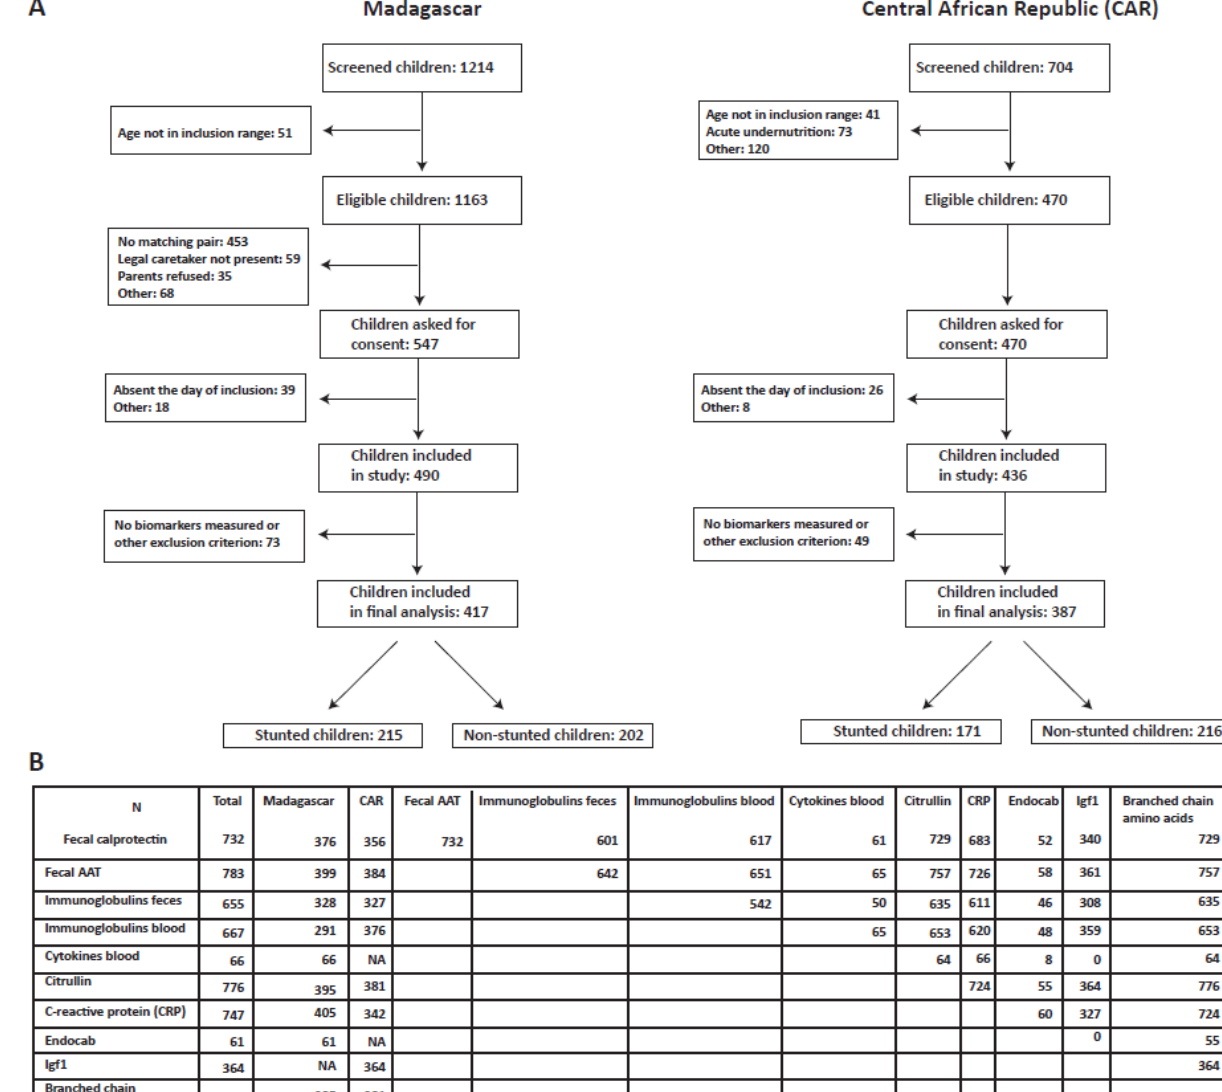
Figure 1. Subjects and samples included in this study: ( A ) flowchart of the subjects included in this study; ( B ) summary of the samples available for each biomarker/ combination of biomarkers.